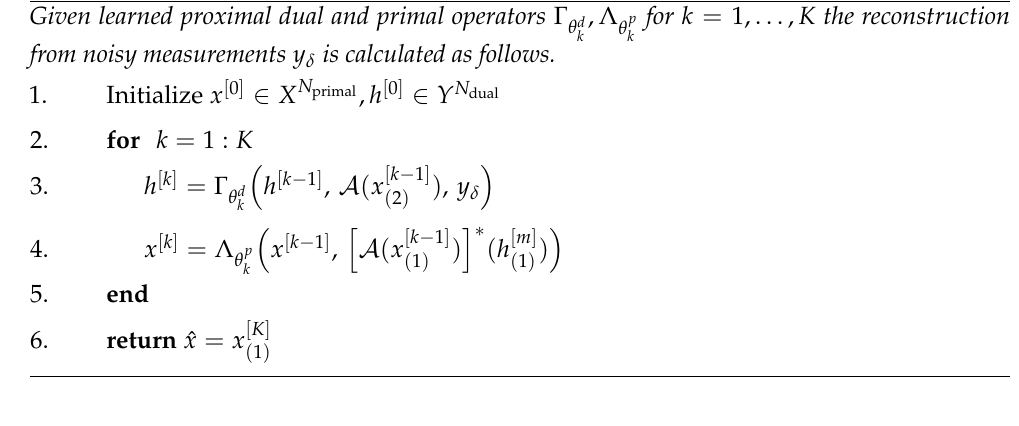
Algorithm A1 Learned Primal-Dual.